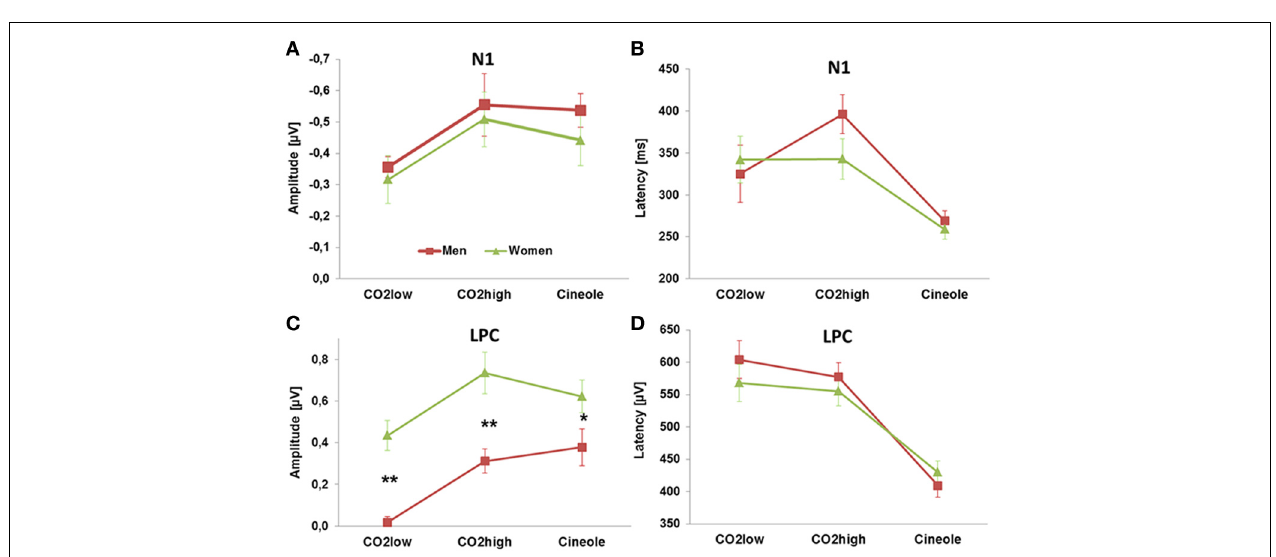
FIGURE 3 | The amplitudes and latencies of the N1 (A,B) and LPC (C,D) deflections showed effects of stimulants. Sex-related ERP effects were found only for the amplitude of the LPC (C) . ∗∗ p < 0 . 001, ∗ p < 0 .